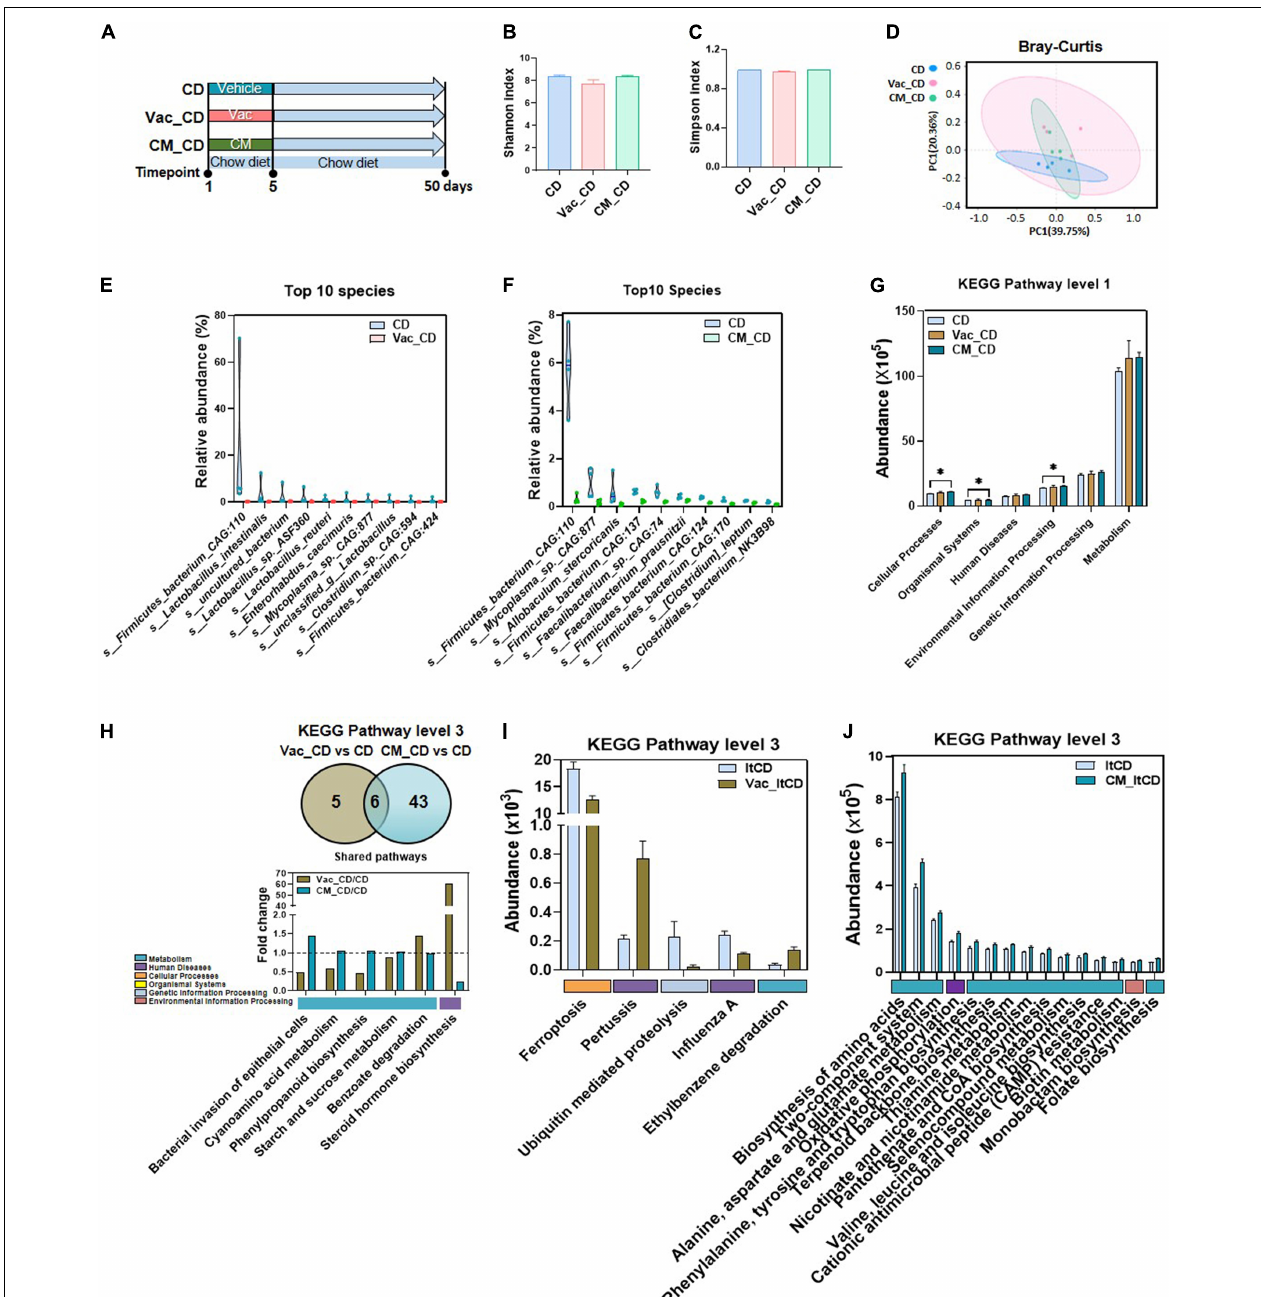
FIGURE 3 | The long-lasting impact of antibiotic treatment on bacterial composition and function when rats were fed with chow diet. (A) Intervention process chart. Rats were treated with vehicle, Vac, or CM for 5 days and then fed with chow diet for another 45 days. (B) Shannon index. (C) Simpson index. (D) Principal co-ordinate analysis based on the Bray–Curtis distance algorithm on species level. (E,F) Top 10 differential species between Vac_CD and CD and between CM_CD and CD ( p < 0.05 by the Mann–Whitney U test). (G) The function differences among groups on KEGG pathway level 1 predicted by PICRUSt2. * p < 0.05 by Student’s t -test. (H) Venn diagram of the overlap of differential enriched pathways between Vac_CD vs. CD and CM_CD vs. CD by PICRUSt2 analysis on KEGG pathway level 3 ( p < 0.05 under the Mann–Whitney U test). The overlapped pathways between Vac_CD vs. CD and CM_CD vs. CD. (I) The unique shifted pathways between Vac_CD and CD. (J) Top 15 unique shifted pathways between CM_CD and CD.